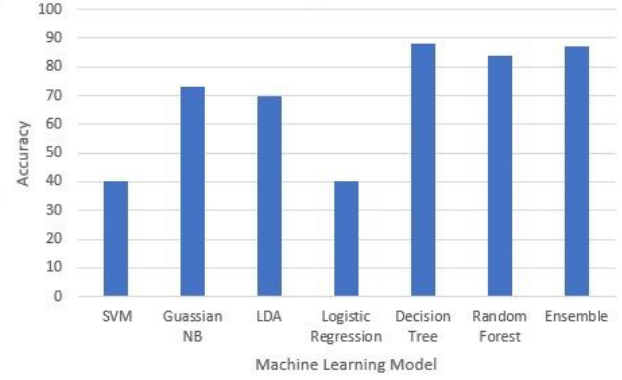
Figure 10. Comparison with existing